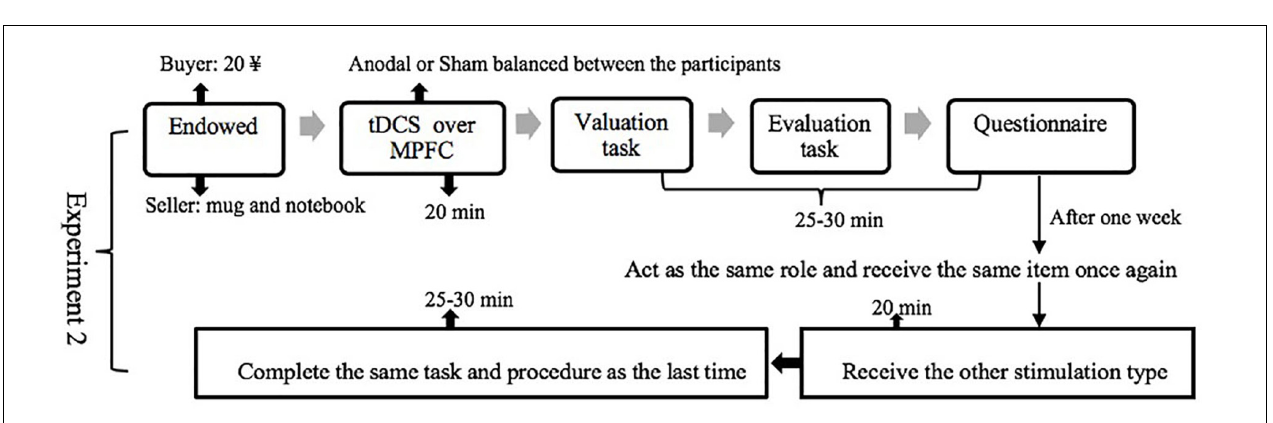
FIGURE 3 | Schematic representation of the experimental design in Experiment 1. After 20 min of stimulation, the participant was asked to complete a valuation task and an evaluation task one by one.